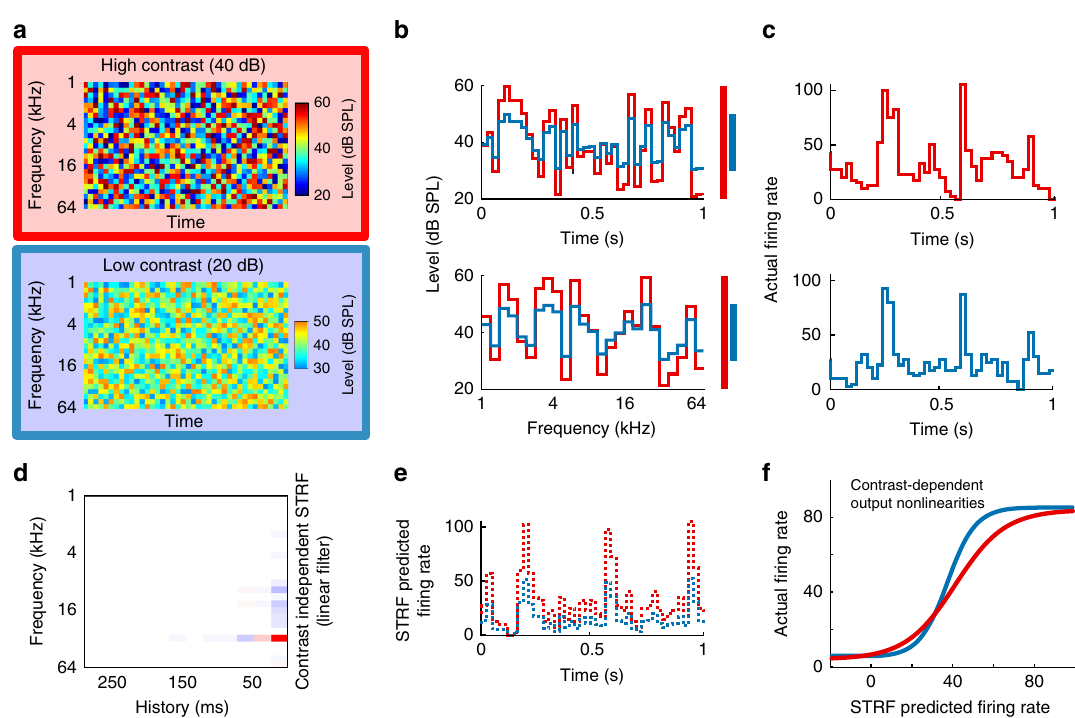
Fig. 2 Stimulus paradigm for electrophysiological experiments and schematic of linear – nonlinear contrast-dependent model of auditory neurons. a Spectrograms of snippets (1,000 ms duration) of DRCs with high (red) or low (blue) contrast. b Cross-section through an example frequency channel (top) and time point (bottom) of DRCs. Colored bars indicate the sound level range for high (red) and low (blue) contrast. c Example peri-stimulus time histograms (PSTHs) during DRC stimulation with high- (top) and low- (bottom) contrast DRCs. d Spectro-temporal receptive fi eld (STRF) describing the best- fi t linear relationship between stimulus structure and the response of an example neuron (red: positive, white: 0, blue: negative). e Example of 1 s of predicted neuronal response to DRCs with high (red) and low contrast (blue), based on the linear STRF model. f Sigmoidal contrast-dependent output nonlinearities for an example unit, modeling the relationship between the actual responses of the unit under high- (red) and low- (blue) contrast conditions and the predicted responses of the STRF linear